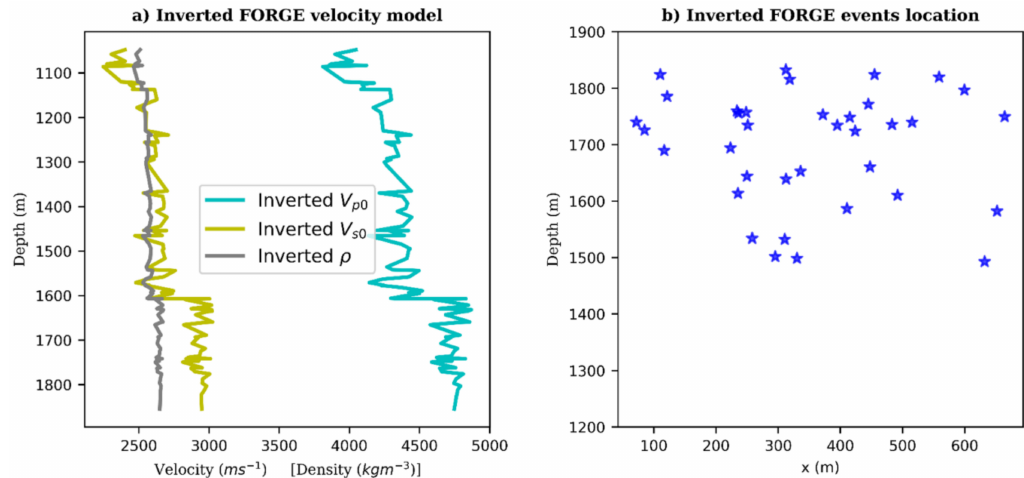
Figure 11. Inversion results: ( a ) Velocity model of FORGE estimated by the neural network. Cyan, yellow and grey curves are the raw patterns output of v p0 , v s0 and ρ by the network, ( b ) Events